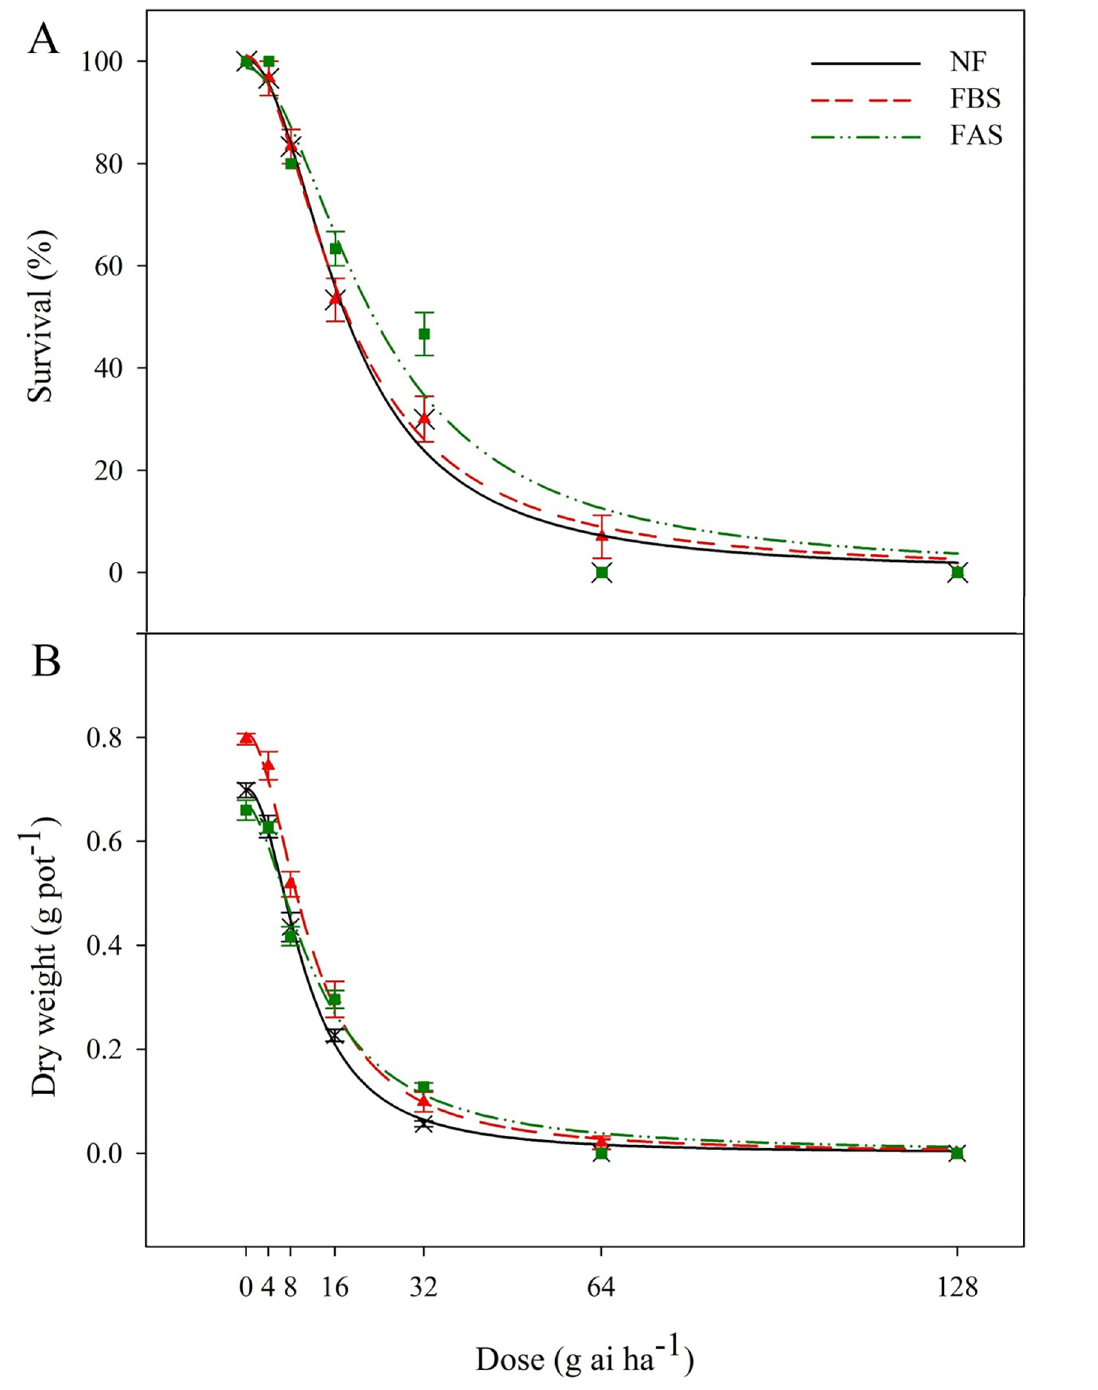
Fig 4. Survival (A) and dry weight (B) of winter wild oat treated with various doses of clodinafop-propargyl under different freezing treatments. Abbreviation: NF (no freezing); FBS (freezing before spray): FAS (freezing after spray). The recommended dose of clodinafop-propargyl in Iran is 64 g ha -1